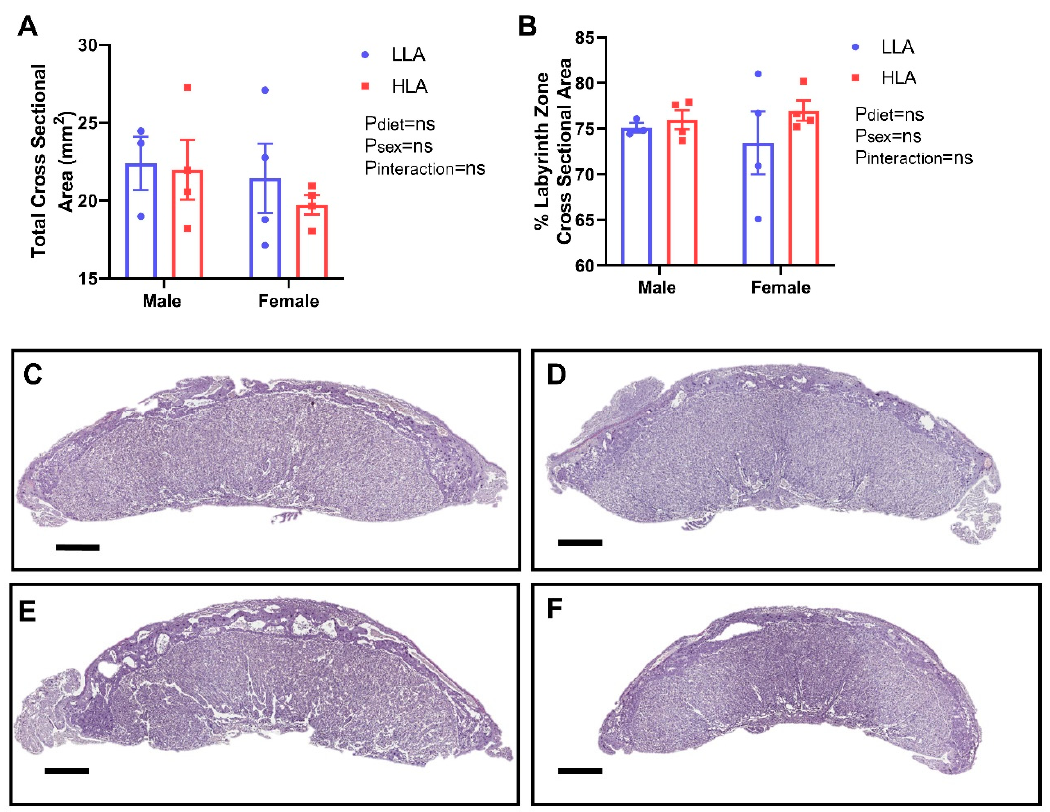
Figure 2. The effect of maternal diet high in linoleic acid on gross placental morphology at embryonic day 20. ( A ) Average total cross-sectional area (mm 2 ) in male and female placentae. ( B ) Percentage labyrinth zone of total cross-sectional area in male and female placentae. ( C ) Representative placental sections of LLA male placenta. ( D ) Representative placental sections of LLA female placenta ( E ) Representative placental sections of HLA male placenta. ( F ) Representative placental sections of HLA female placenta stained with H-E at 1 × magnification (scale bar = 1000 µ m). n = 3–4. Data are presented as mean ± SEM with each dot on the scatter plot symbolizing a single representative sample taken from each litter. Data was analyzed using a two-way ANOVA with diet and sex as two factors. LLA = low linoleic acid; HLA = high linoleic